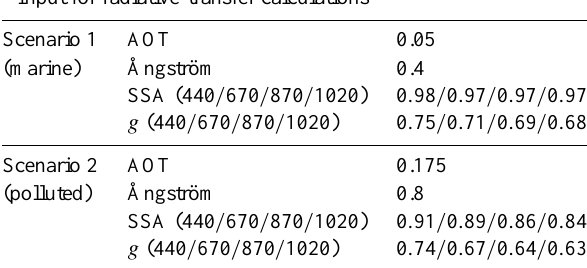
Table 1. Input parameter for simplified radiative-transfer calcula- tions. Mean aerosol optical thickness (AOT) for marine conditions is taken from Smirnov et al. (2009), single-scattering albedo (SSA) and asymmetry parameter ( g ) are taken from Dubovik et al. (2002).